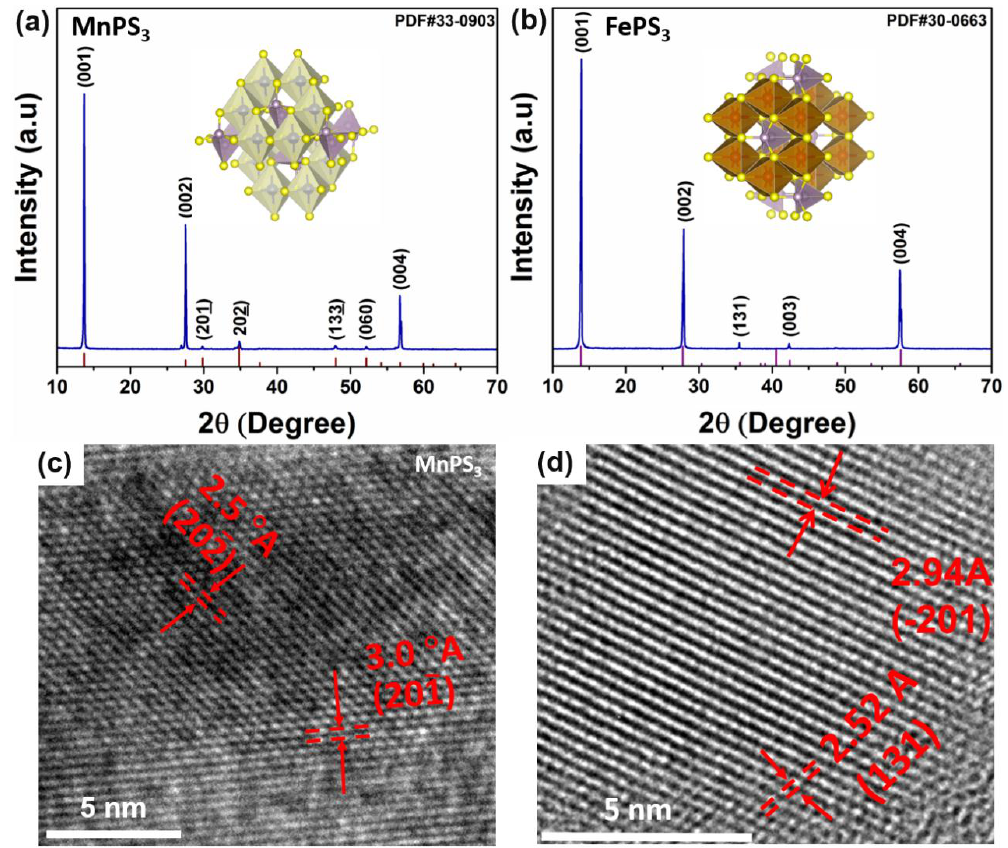
Figure 2. ( a , b ) X-ray diffraction patterns and ( c , d ) high resolution transmission electron microscope (TEM) images for MnPS 3 and FePS 3 single crystals prepared by ball-milling and sonication process.